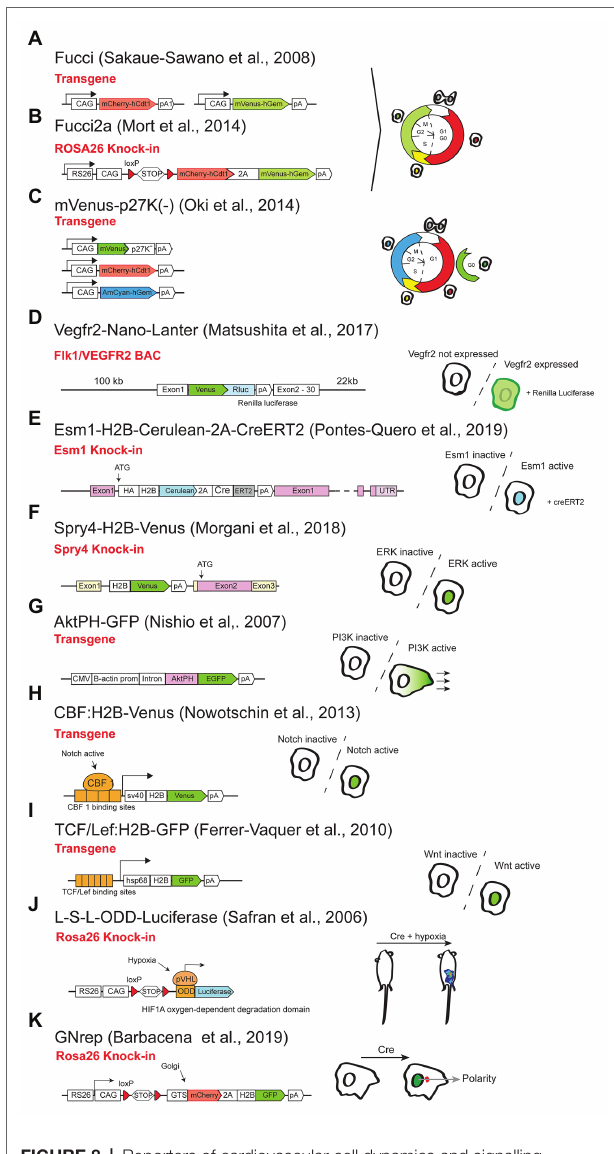
FIGURE 8 | Reporters of cardiovascular cell dynamics and signalling. Representation of the different reporter alleles on the left. On the right is possible to see the type of cell labelling achieved according to the stage of the cell-cycle or cell signalling/polarity